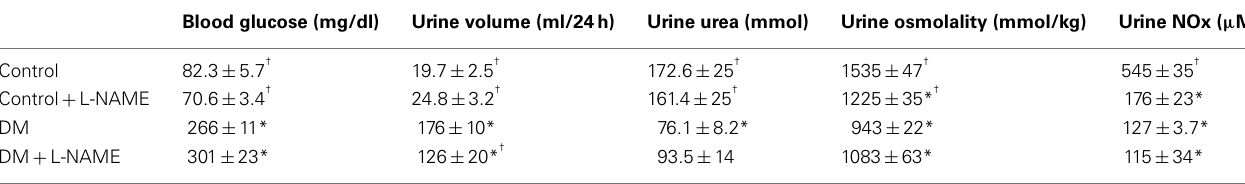
Table 1 | Effects of L-NAME administration on control and diabetic rats.